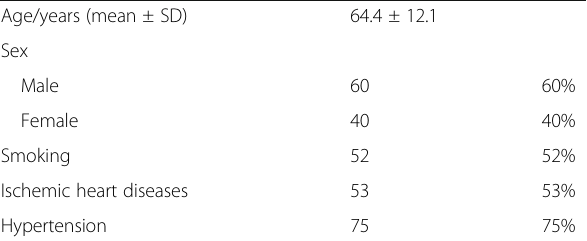
Table 1 Basic data of cerebrovascular stroke